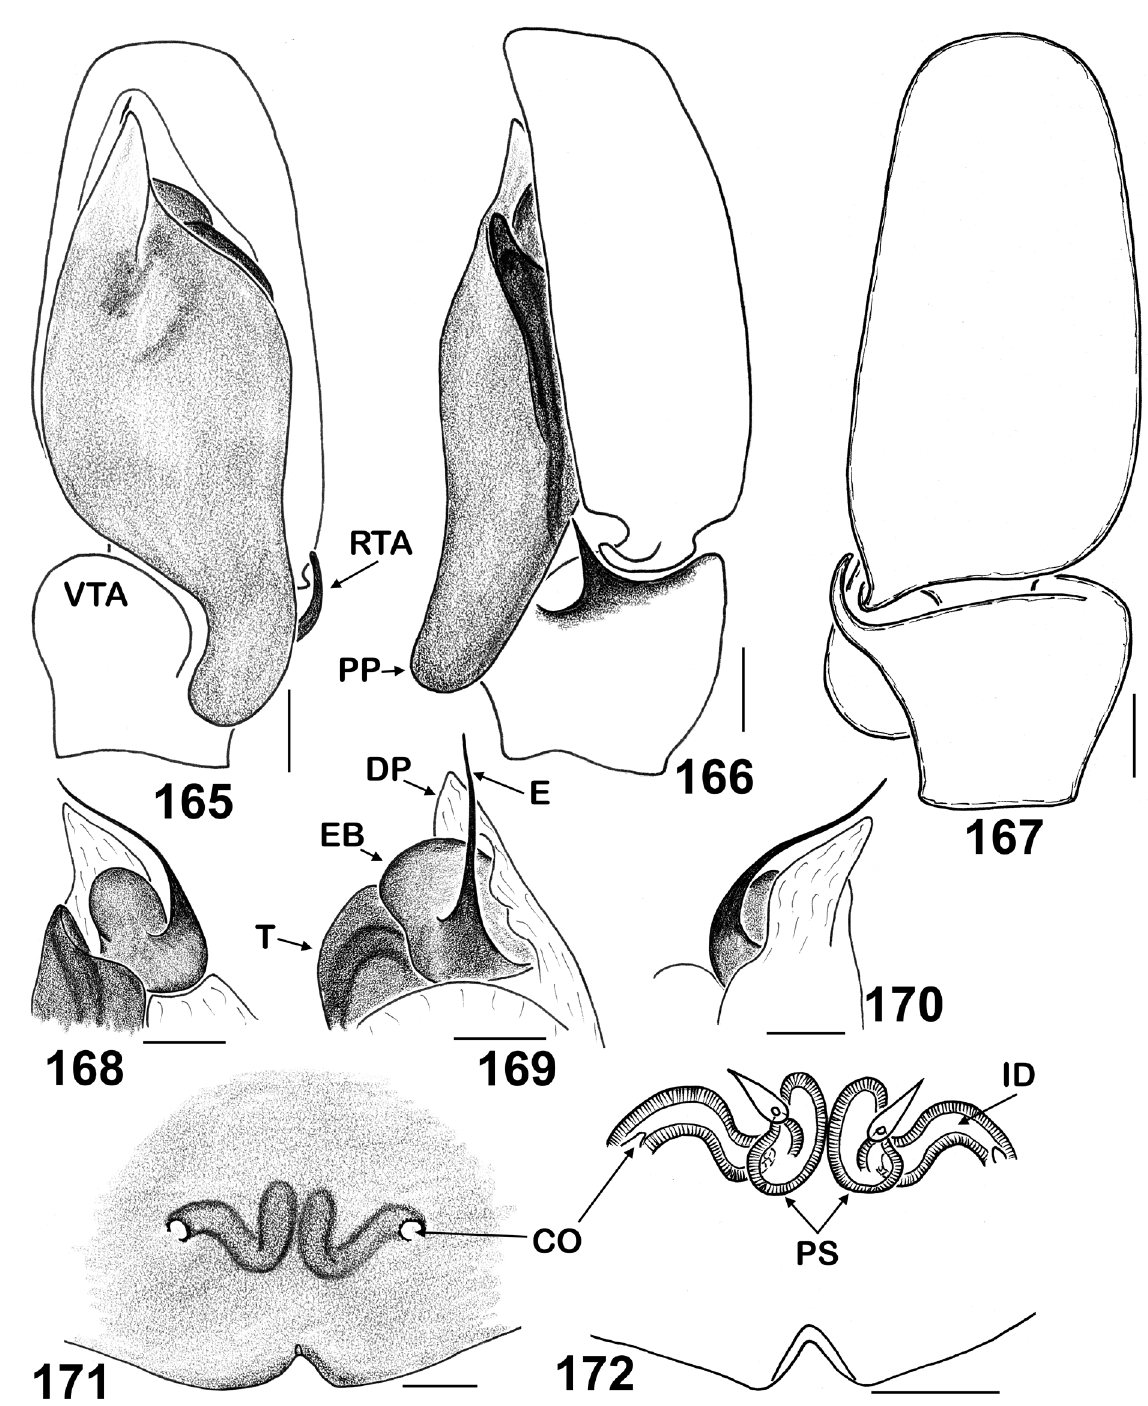
Figs 165–172. Stenaelurillus guttatus (Wesołowska & Cumming, 2002) comb. nov., holotype, ♂ (165–170) and paratype, ♀ (171–172) . 165 . Male palp, ventral view. 166 . Male palp, retrolateral view. 167 . Male palp, dorsal view. 168 . Embolic division, dorsal view. 169 . Embolic division, median view. 170 . Embolic division, retrolateral view. 171 . Epigyne, ventral view. 172 . Spermathecae, dorsal view. Abbreviations: see Material and methods. Scale bars: 0.1